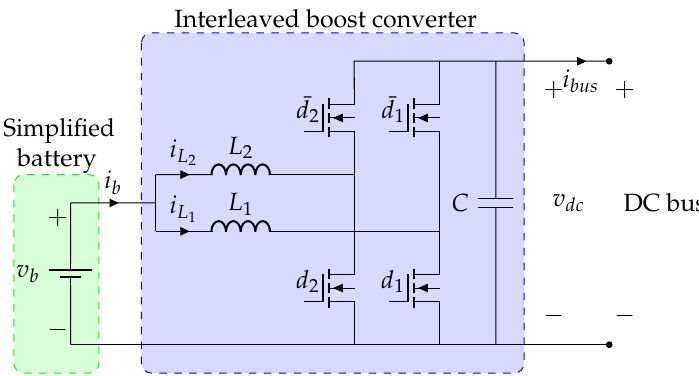
Figure 2. Electrical connection of an interleaved boost